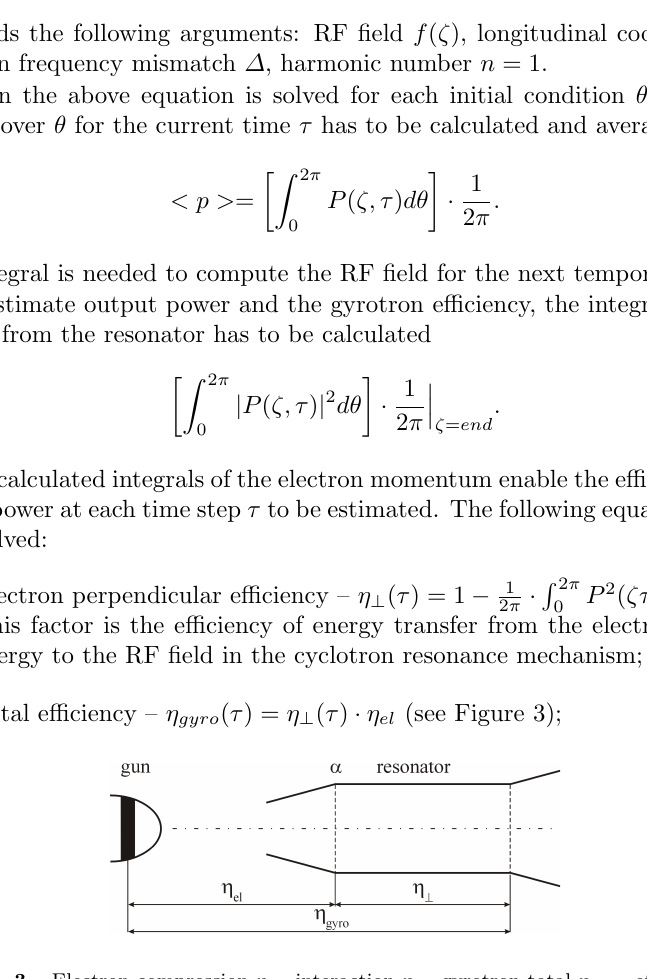
Figure 3. Electron compression η el , interaction η ⊥ , gyrotron total η gyro